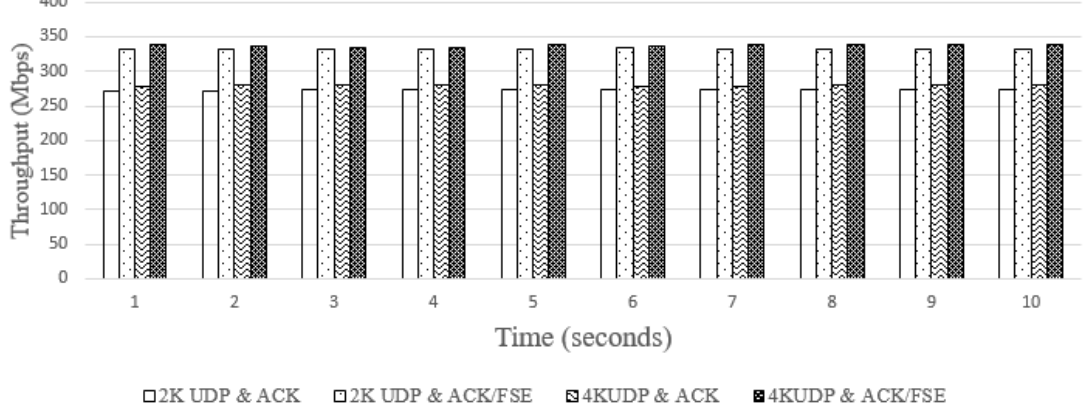
Figure 18. End-to-end throughput with mmWave